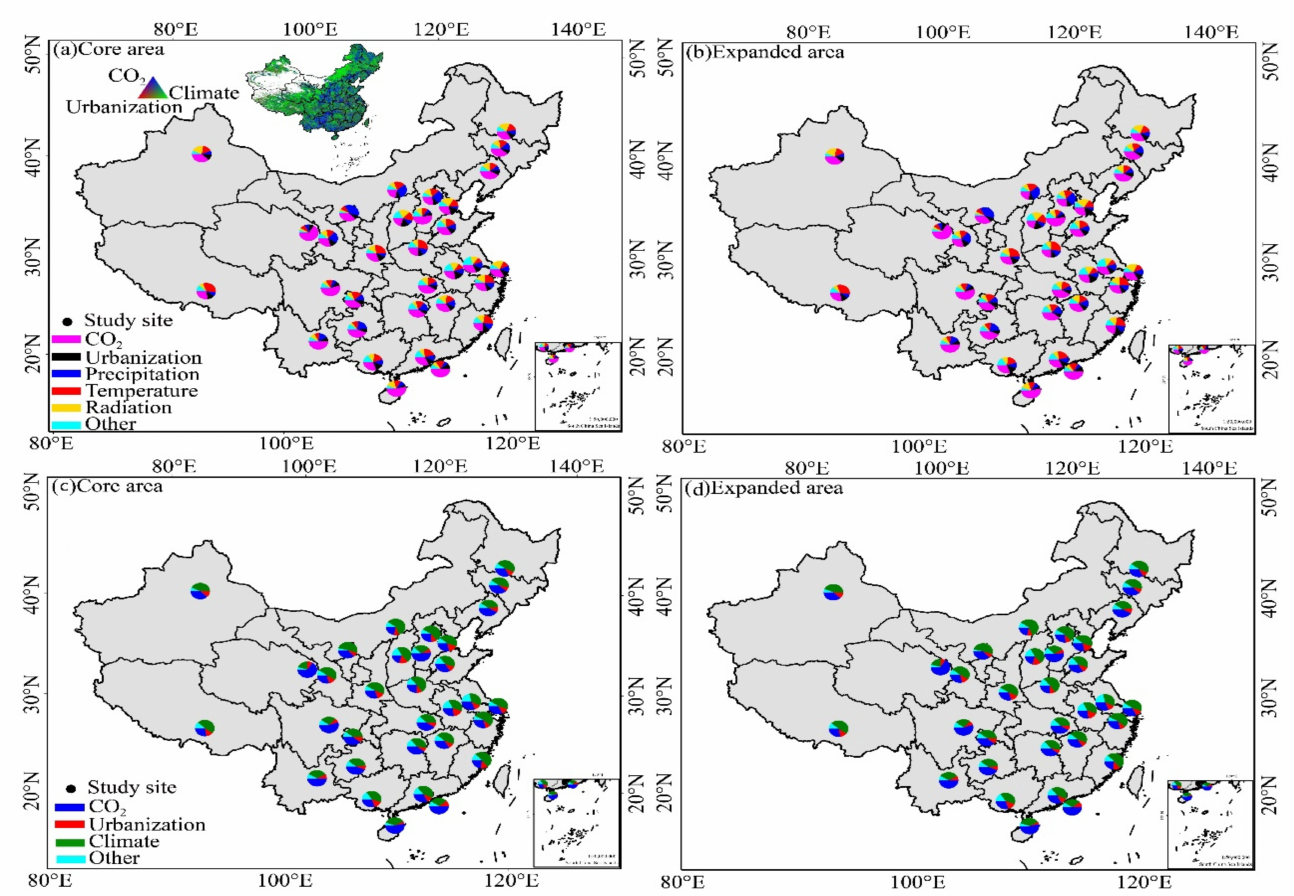
Figure 8. Driving factor contributions in 32 major cities in China: ( a ) pie chart of five driving factor contributions in the core region, ( b ) pie chart of five driving factor contributions in the expansion region, ( c ) pie chart of three major driving factor contributions in the core region, and ( d ) pie chart of three major driving factor contributions in the expansion